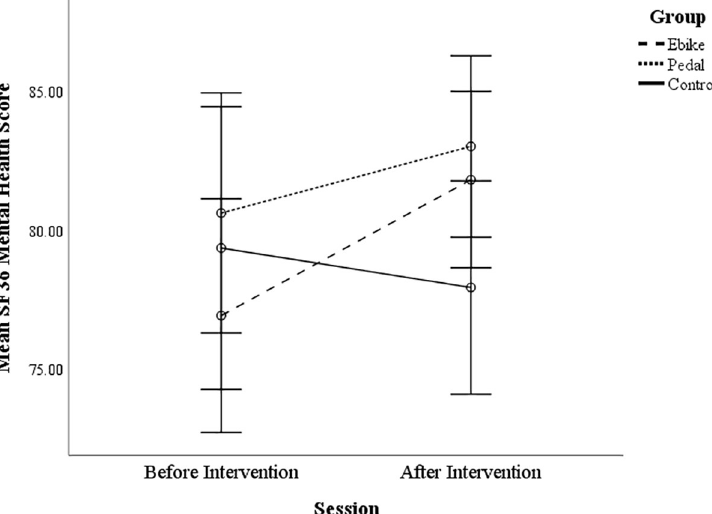
Fig 4. SF-36 mental health component for the non-cycling controls, e-bike cyclists and pedal cyclists before and after the intervention. Error bars are +/- 2 SEs.